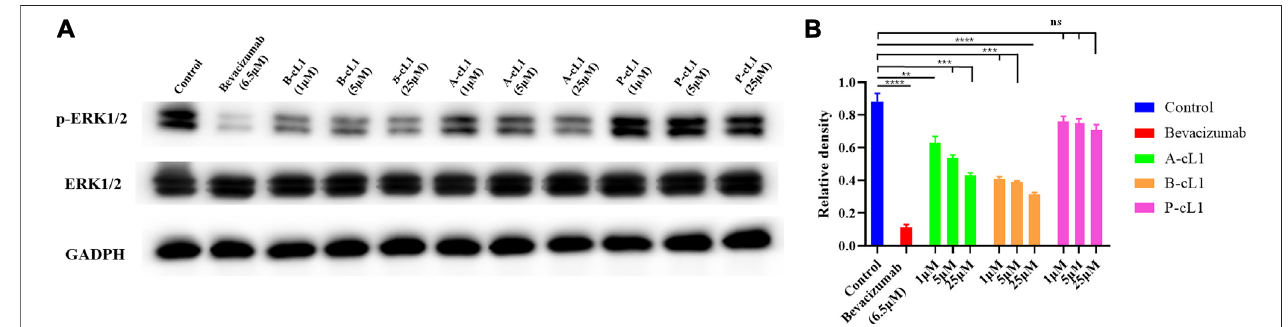
FIGURE 6 | A-cL1, B-cL1, and P-cL1 inhibit p-ERK1/2 formation by inhibiting VEGF/VEGFRs interaction. (A) Western blots using p-ERK1/2 and total ERK1/2 extractsofHUVECsaftertreatmenteitherwithA-cL1,B-cL1orP-cL1(1 μ M,5and25 μ M),orwithbevacizumab(6.5 μ M)aspositivecontrol,orwithserum-freemedium (control group). GAPDH was used as loading control. (B) Quanti fi cation of relative density of p-ERK1/2 and total ERK1/2 were analyzed by ImageJ. The bar chart illustratesrelativedensityvaluesthatanalyzedusingGraphPadPrism8.Dataarepresentedasmean ± SEMofthreeexperiments,comparedtothecontrolgroupin one-way ANOVA statistical analysis. * p < 0.05, ** p < 0.01, *** p < 0.001, **** p < 0.0001, “ ns ” meaning non-signi fi